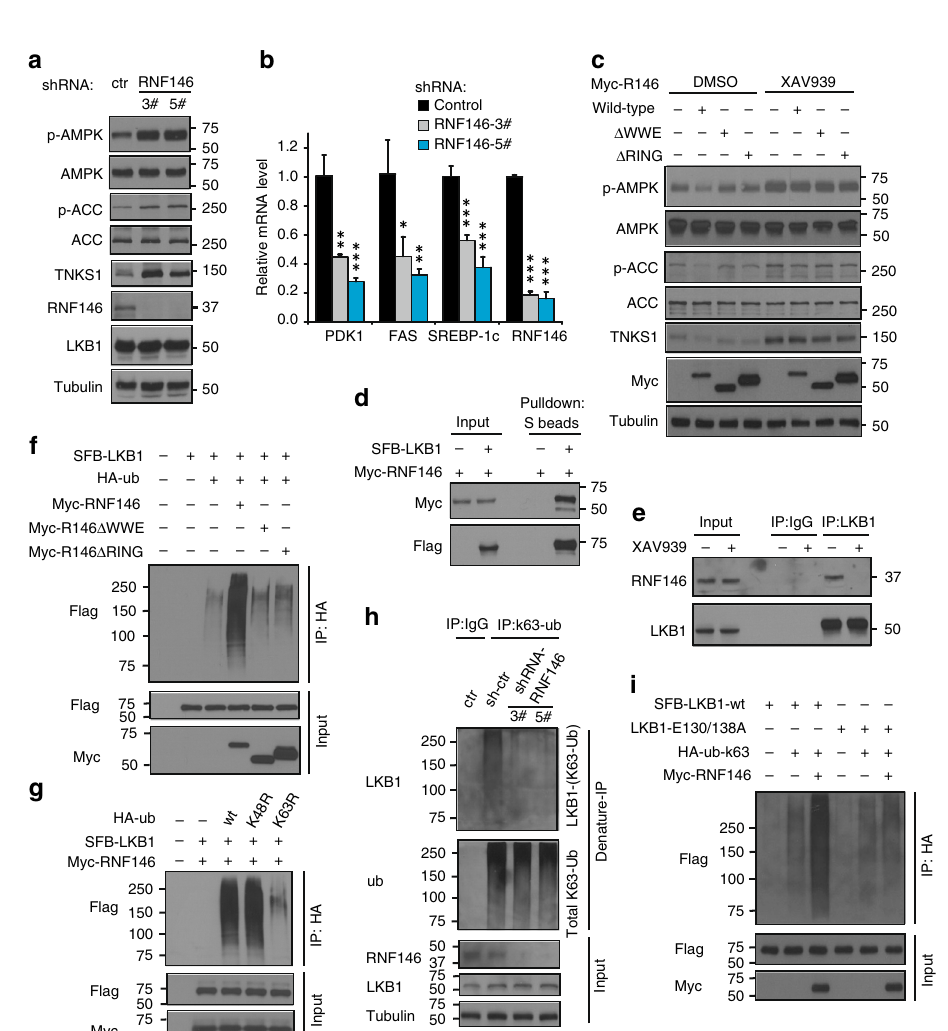
Fig. 3 RNF146 is Involved in Regulation of the LKB1-AMPK Pathway Through K63-Linked LKB1 Ubiquitination. a Knockdown of RNF146 leads to AMPK activation. HEK293A cells were transduced with the indicated shRNA and subjected to western blotting. b Loss of RNF146 suppresses expression of AMPK downstream glycolytic genes. The relative expression levels of PDK1, FAS, and SREBP-1c were detected by qPCR. c , Both the WWE and RING domains of RNF146 are required for suppression of AMPK phosphorylation. d LKB1 interacts with RNF146. Myc-tagged RNF146 was co-expressed with or without SFB- LKB1 and cell lysates were subjected to pull-down assay. e Interaction between LKB1 and RNF146 is blocked by tankyrase inhibitor. f RNF146 induces LKB1 ubiquitination in vivo. In vivo ubiquitination assay was assessed in 293 T cells transfected with the indicated constructs followed by western blotting. g RNF146 promotes LKB1 ubiquitination through K63-linkage. 293 T cells were transfected with the indicated plasmids, and subjected to an in vivo ubiquitination assay. h RNF146 depletion diminishes K63-linked LKB1 ubiquitination. K63-linked ubiquitination of endogenous LKB1 was detected by denature-IP using a K63-speci fi c ubiquitin antibody. i RNF146 doesn ’ t affect K63-linked ubiquitination of the LKB1-E130/138 A mutant. In vivo ubiquitination assay was performed in 293 T cells transfected with the indicated constructs. Statistical signi fi cance was determined by a two-tailed, unpaired Student ’ s t -test. * P < 0.05; ** P < 0.01; *** P <